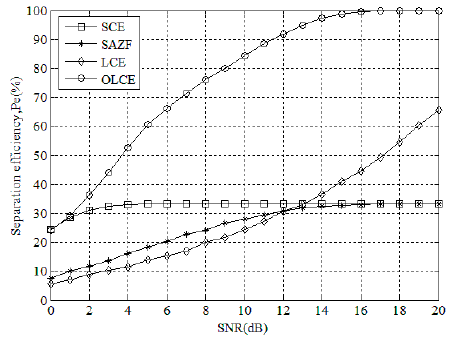
Figure 7. Separation efficiency for SCE, SAZE, LCE, and OLCE under different SNR when the number of collided tags is three.